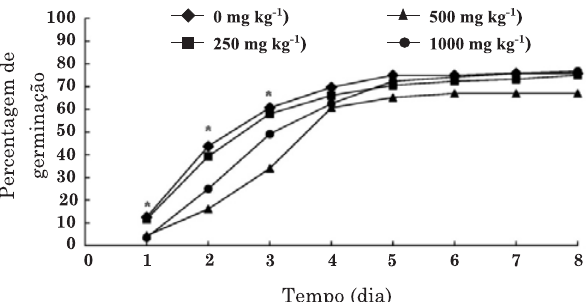
Figura 1. Percentagem de germinação de sementes de Stizolobium aterrimum em resposta ao aumento da dose de Pb no solo. (*: diferença significativa entre tratamentos com diferentes doses de